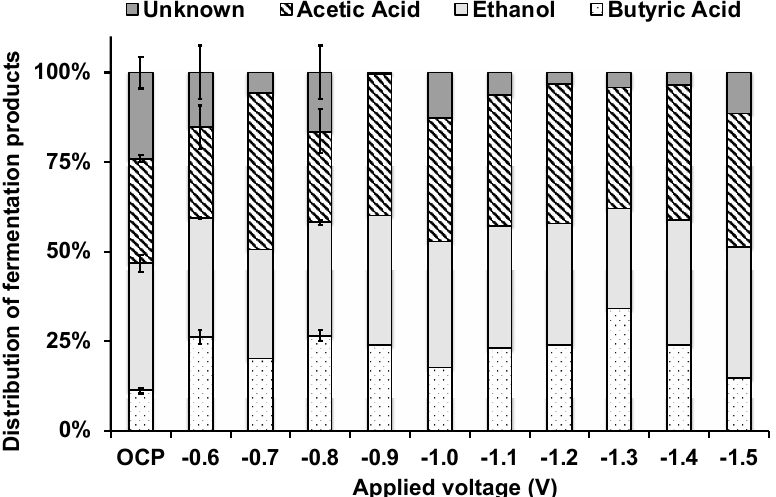
Figure 3. Percentage distribution of measured fermentation products calculated at the end of the batch experiments under OCP and EF conditions (error bars represent the standard error of replicated experiments).